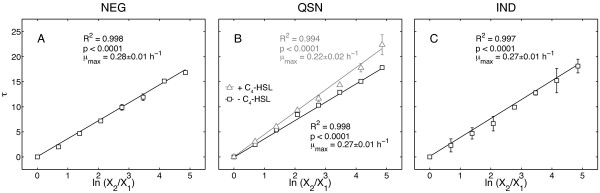
Determination of the reproducibility of the lag phase in NEG, QSN and IND. For NEG, τ shows a correlation to ln (X2/X1) with an R2 of 0.998 (p < 0.0001) and a μmax of 0.28 ± 0.01 h-1. The median and range over two independent experiments are plotted as squares and error bars. For QSN in the absence of autoinducer, τ shows a correlation to ln (X2/X1) with an R2 of 0.998 (p < 0.0001) and a μmax of 0.27 ± 0.01 h-1. In the presence of C4-HSL τ shows a correlation to ln (X2/X1) with an R2 of 0.994 (p < 0.0001) and a μmax of 0.22 ± 0.02 h-1. The median and range over two independent experiments are plotted as black squares (without autoinducer) or gray triangles (with autoinducer) with their respective error bars. For IND, τ shows a correlation to ln (X2/X1) with an R2 of 0.997 (p < 0.0001) and a μmax of 0.27 ± 0.01 h-1. The median and range over two independent experiments are plotted as squares and error bars.